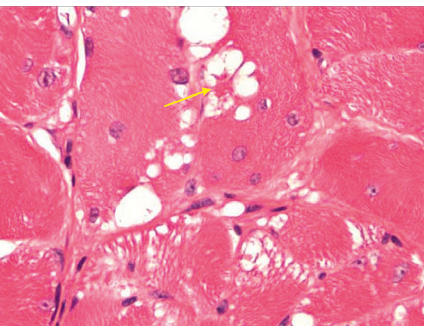
Figure 4: 40x magnification of H&E stained histology specimen of rhabdomyoma shows tightly packed polygonal cells separated by thin fibrous septa, vascular channels, striated cytoplasm, and spider cells (arrow), characterized by a central acidophilic mass connected to a condensed rim of cytoplasm at the periphery by thin strands of cytoplasm. Mitotic figures and evidence of necrosis are